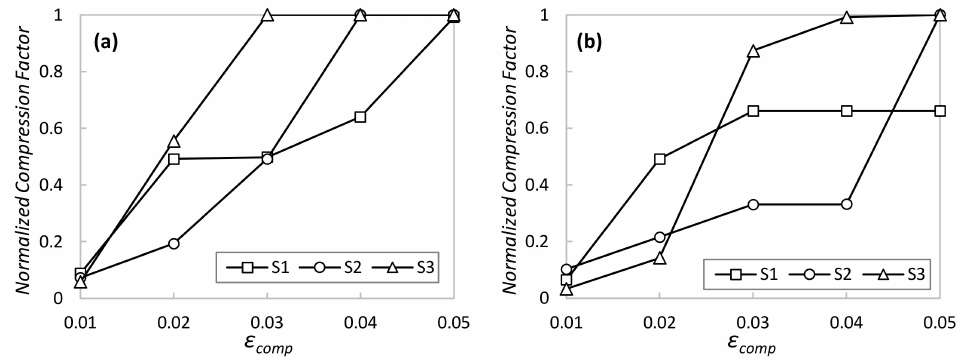
Figure 5. AAC performance under normal operation ( a ) and operation with perturbations ( b ).